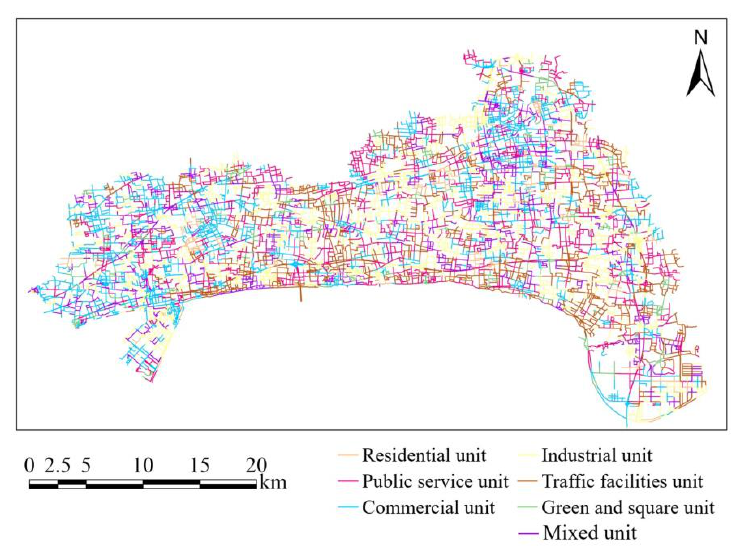
Figure 8. City H urban functional area distribution map.